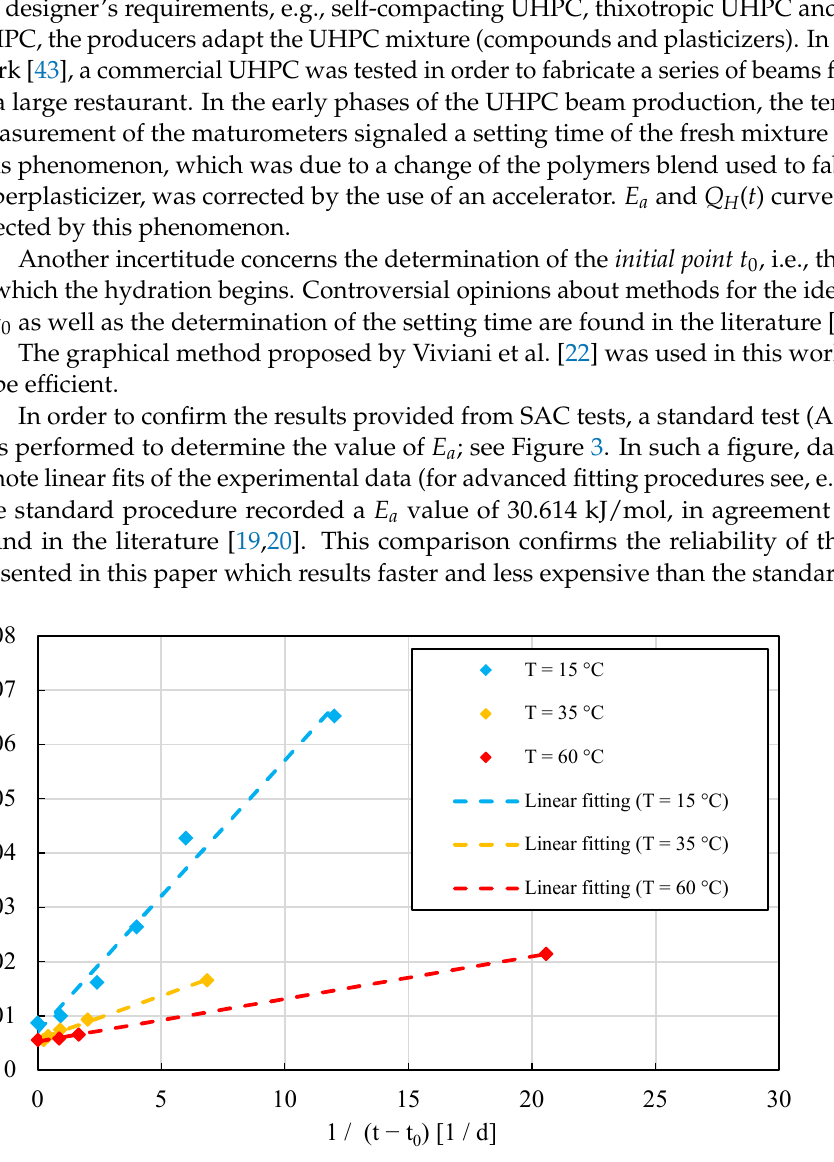
Figure 3. Determination of E a for UHPC series according to standard test (ASTM 1074). Each point corresponds to the mean value among 3 to 4 observations.